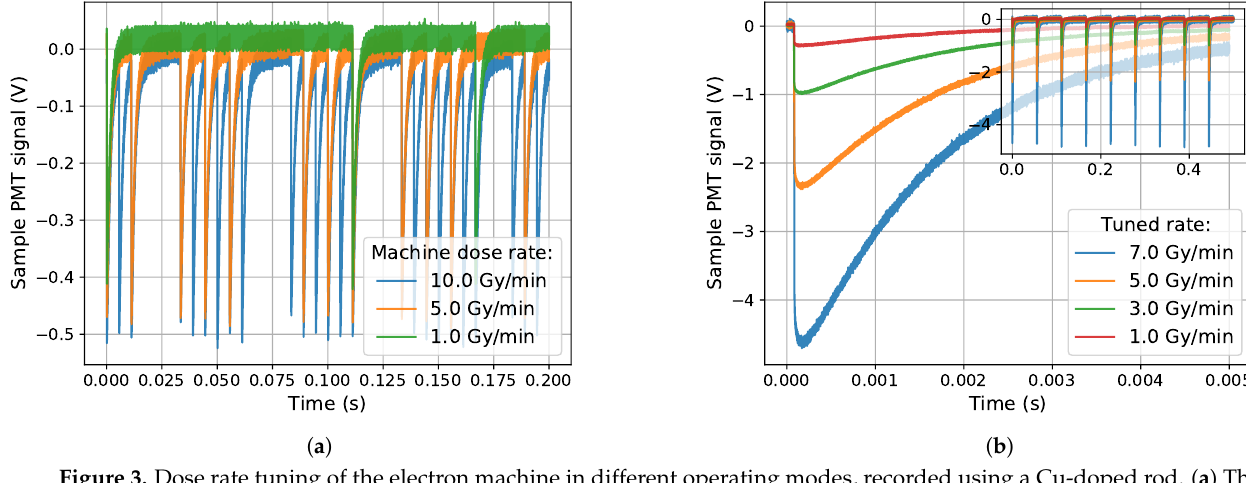
Figure 3. Dose rate tuning of the electron machine in different operating modes, recorded using a Cu-doped rod. ( a ) The standard dose rate tuning scheme is shown in the figure, where the bunch frequency is automatically modulated while the bunch sizes are kept constant. ( b ) The operation mode used in the experiments, where the bunch frequency is kept constant (shown in the figure inset) while the electron bunch size is tuned (see the varying size of the PMT